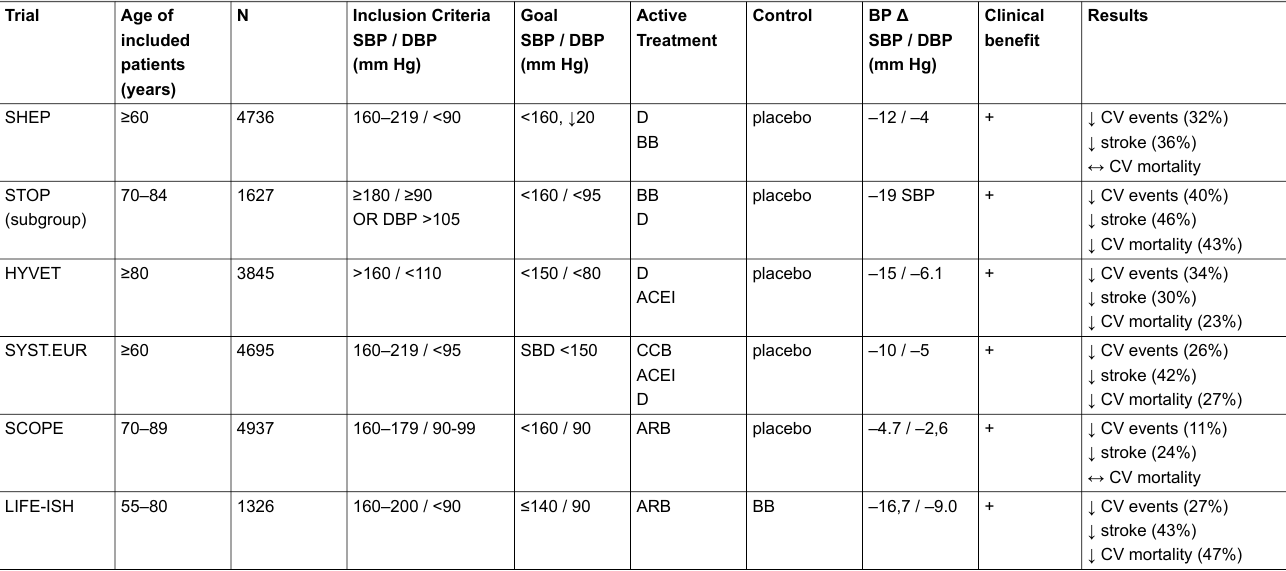
Table 1: Summary of important outcome trials for patients in the elderly and very elderly.